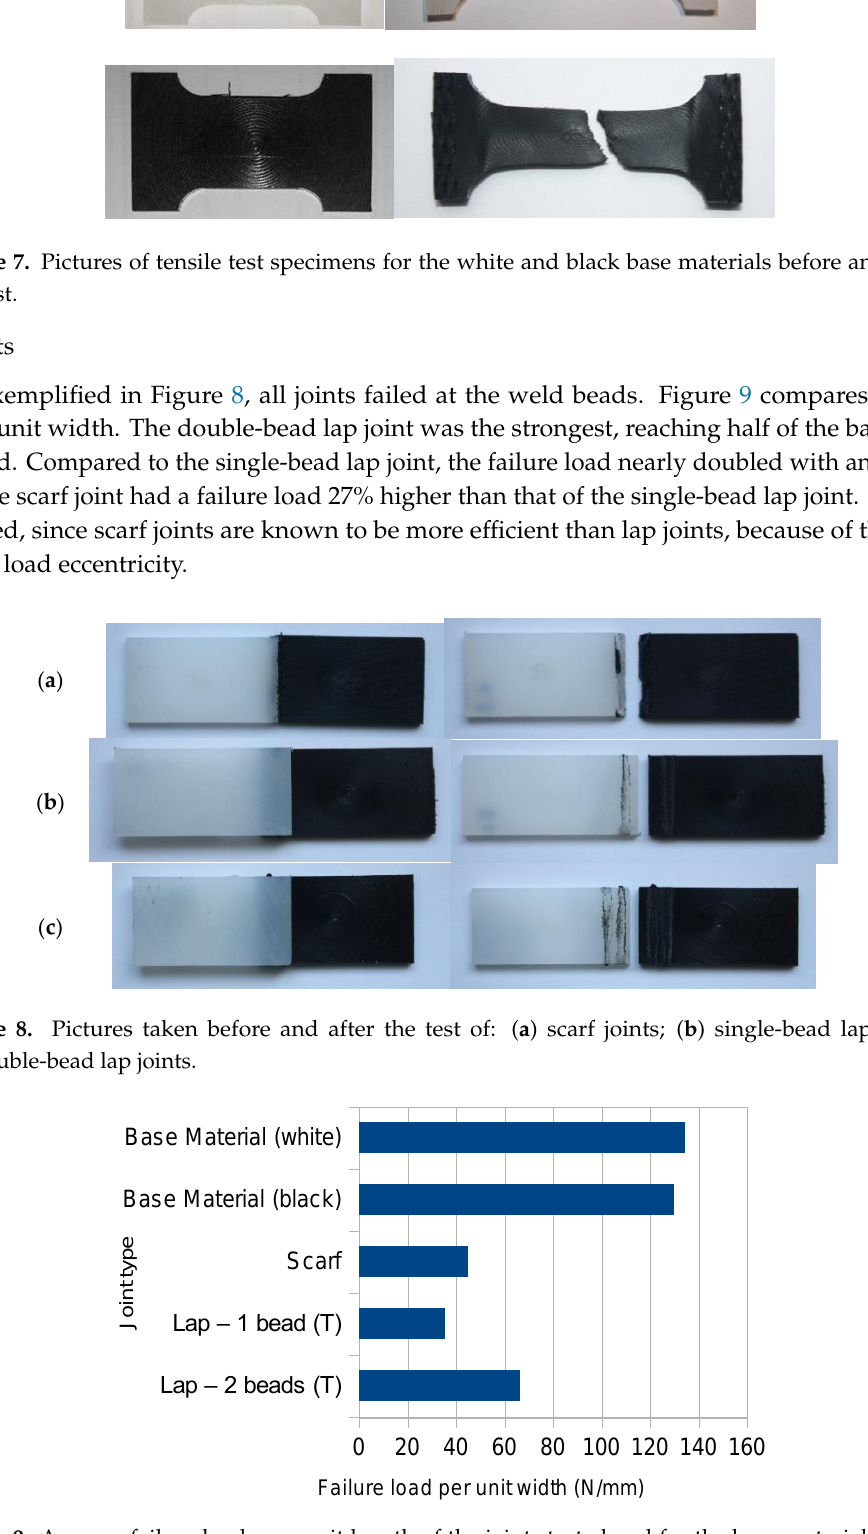
Figure 9. Average failure loads per unit length of the joints tested and for the base material tensile test specimens.